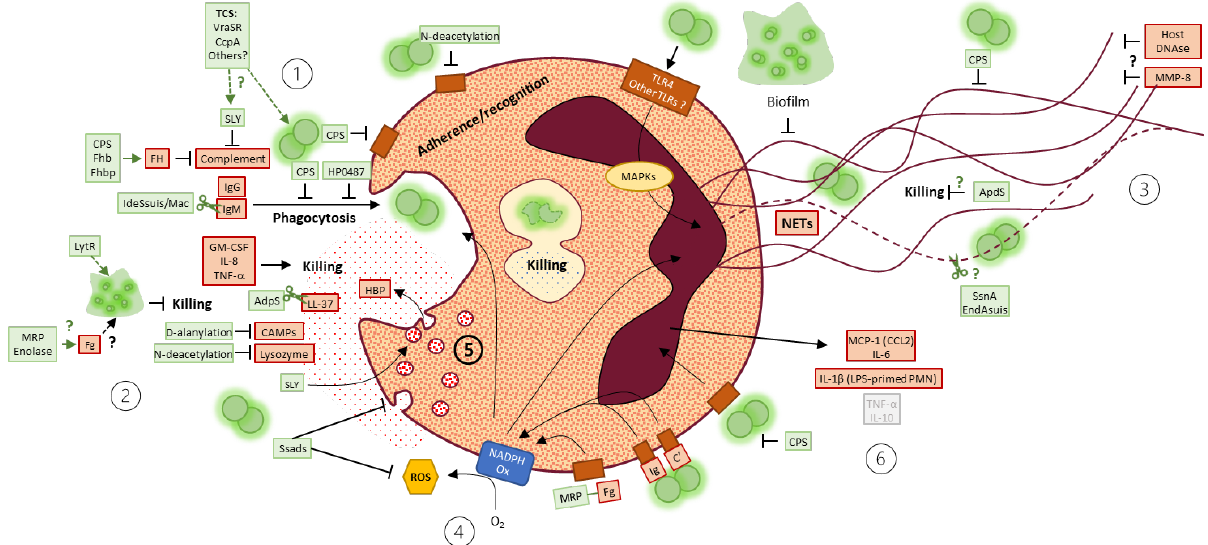
Figure 5. Mechanisms of S. suis interference with neutrophil functions (including findings from porcine, murine and human models). In orange are indicated host factors and in green, S. suis factors. An arrow represents an activation, a production or an enhancement, while a “T” represents an inhibition/reduction. The scissors symbol refers to a cleavage mechanism. A question mark indicates a mechanism that remains to be further confirmed. (1) The capsular polysaccharide (CPS) of S. suis avoids recognition by neutrophils partly because of the negative charge of the CPS. Peptidoglycan modifications by N -deacetylation may also limit bacterial recognition. Two-component systems (TCS), such as VraSR and CcpA, can regulate CPS thickness and suilysin (SLY) production. In addition, CPS impairs bacterial phagocytosis/killing by neutrophils, but host complement, IgG and IgM may favor it. However, complement activation may be inhibited by SLY and recruitment of host factor H (FH) at the surface of the bacteria. Indeed, FH is a host factor known to limit complement activation. IgM can be cleaved by IdeSsuis/Mac protease. The surface protein HP0487 may also inhibit phagocytosis. Even if S. suis is poorly phagocytized, an intracellular uptake leads to an efficient killing of the bacteria. (2) Cytokines GM-CSF, IL-8 and TNF- α promote bacterial killing. Host LL-37 acts as an antimicrobial but can be cleaved by S. suis ApdS. Bacterial D -alanylation was suggested to limit the action of cationic antimicrobial peptides (CAMPs), and N -deacetylation of the peptidoglycan might limit S. suis destruction by lysozyme. Formation of biofilm can be induced by bacterial LytR and presence of host fibrinogen (Fg), and limits neutrophil-mediated killing. Bacterial factors MRP and Enolase adhere to Fg and inhibit killing function of neutrophils. However, if this effect is linked to biofilm formation remains to be determined. (3) S. suis induces neutrophil extracellular trap (NET) formation by neutrophils partly through recognition by the Toll-like receptor 4